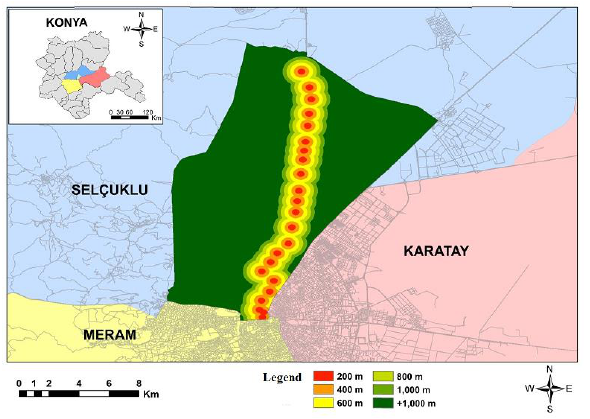
Figure 10. Tram stops density analysis